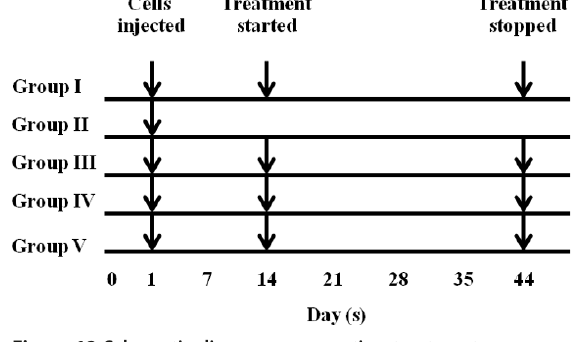
Figure 12 Schematic diagram representing treatment sequence for the evaluation of anticancer activity of CUR compound and plant extracts in CCA-xenografted nude mouse model . Cells injected = subcutaneous injection of CL-6; Treatment started = administration of treatment (CUR compound, each plant extract, vehicle or 5-FU); Treatment stopped = withdrawal of treatment (CUR compound, each plant extract, normal saline or